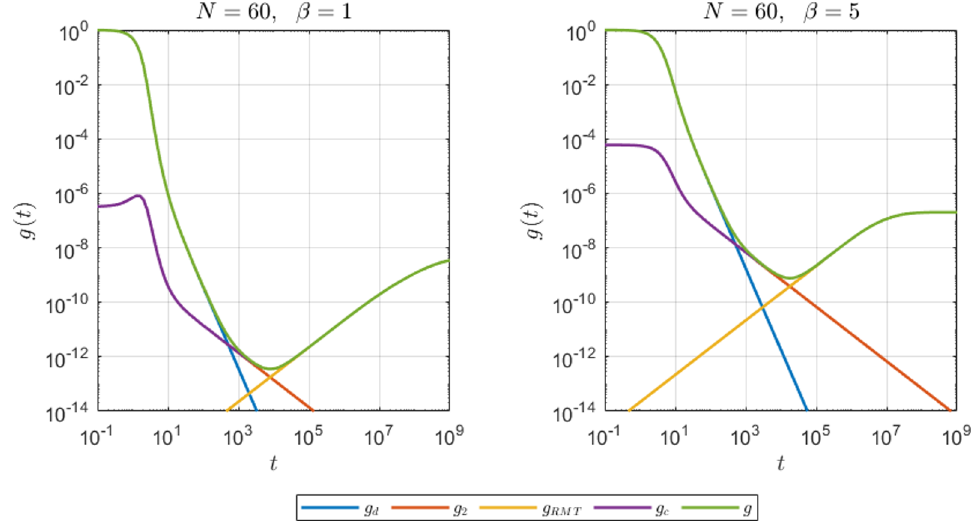
Figure 14 . The approximate spectral form factor as a function of time for N = 60 and p = 4 . There is a clear crossover region around t ∼ 10 3 to t ∼ 10 4 where the spectral form factor is dominated by g 2